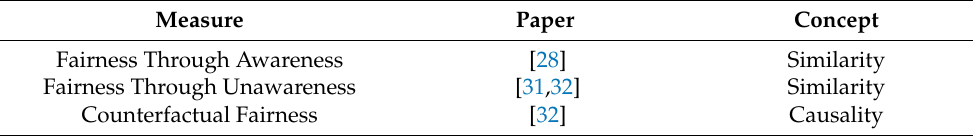
Table 3. Definitions of Individual Fairness adapted from